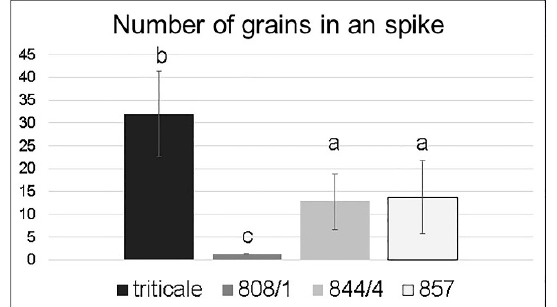
Figure 5. Number of grains per primary spike in the studied lines. Different letters indicate statisti- cally significant differences ( p < 0.01, Student’s t-test).